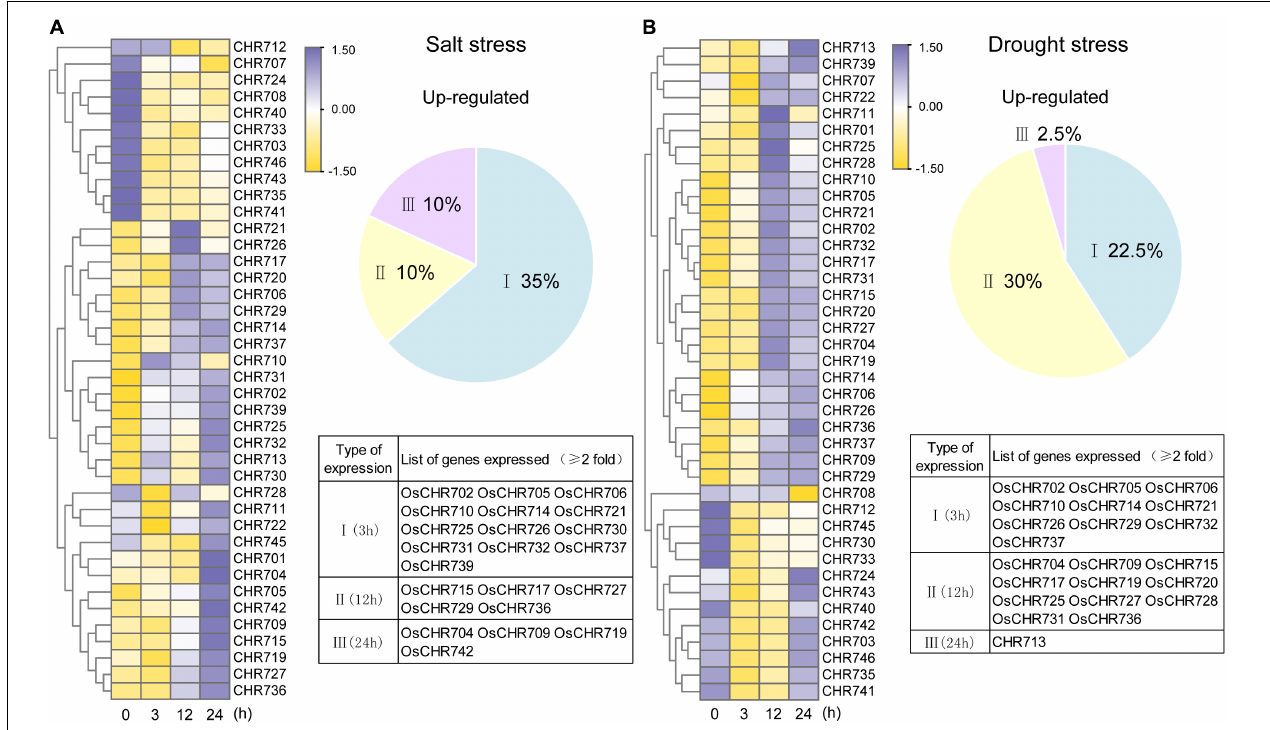
FIGURE 7 | Expression analysis of Snf2 genes under salt and drought stresses. The temporal expression patterns of Snf2 genes under salt (A) and drought (B) stress treatments were presented by a heat map using the heatmap packages in R. The qRT-PCR values were normalized using OsUBQ5 as the internal reference gene and that of the unstressed samples using the (cid:49)(cid:49) C T method. The percentage of genes upregulated (twofold and significant difference than the unstressed samples) under salt and drought treatments is represented in the pie chart beside the corresponding heat maps. The genes were annotated as I (3 h response), II (12 h response), and III (24 h response) types based on their time point of up-regulated expression. The names of the genes are provided in the